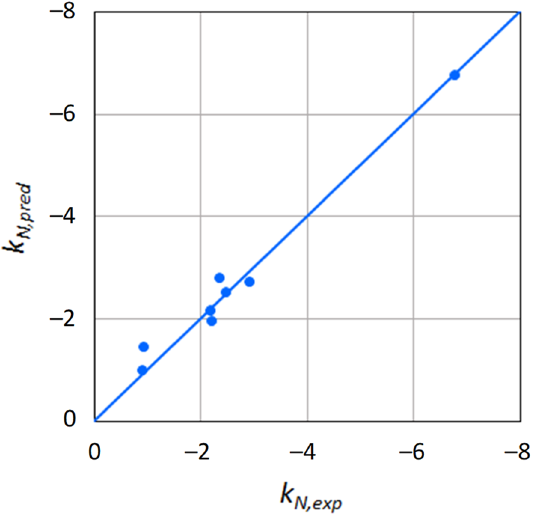
Figure 1. Comparison between experimental ( k N,exp ) and predicted ( k N,pred ) Norrish constants.